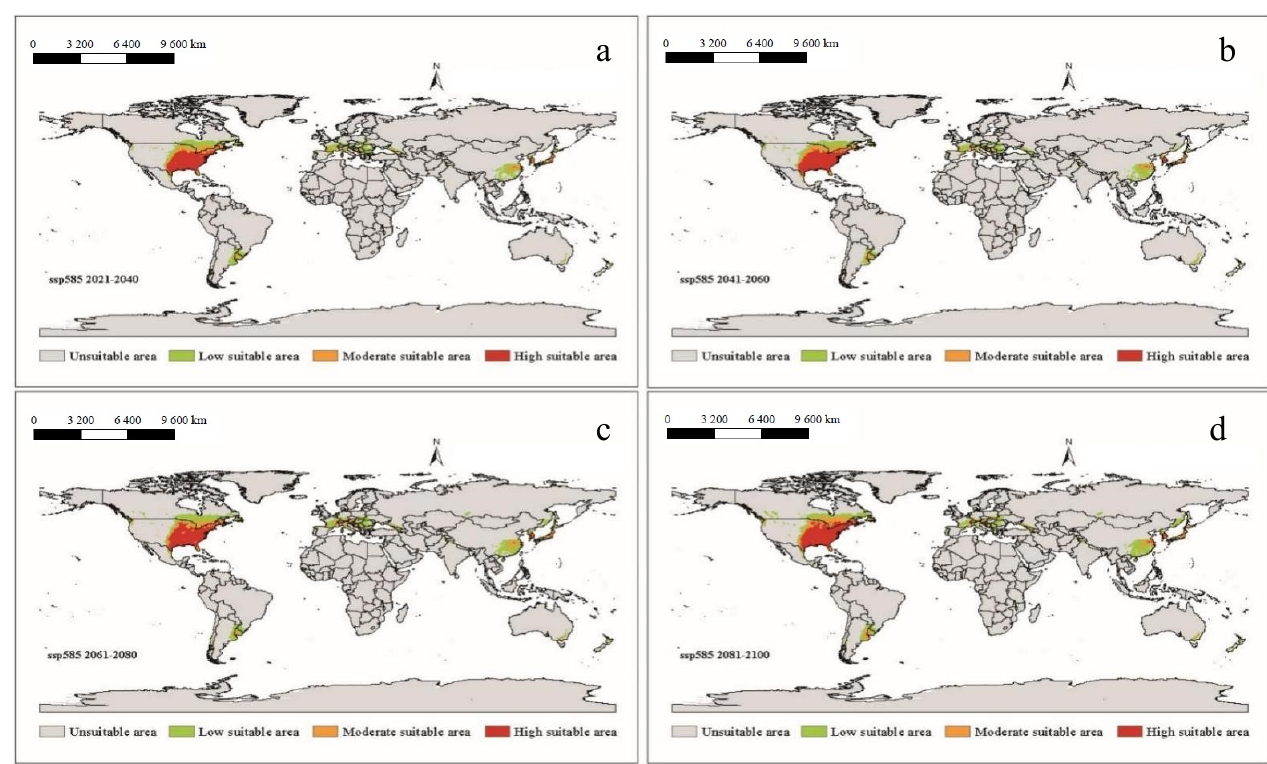
Figure 8. The potential distribution of suitable areas for A. americanum around the world under the climatic conditions of shared socio-economic pathway 3-7.0 (regional rivalry and radiative forcing of 7.0 W/m 2 to 2100) during different periods of the 21st century: ( a ) 2021–2040, ( b ) 2041–2060, ( c ) 2061–2080, ( d ) 2081–2100.